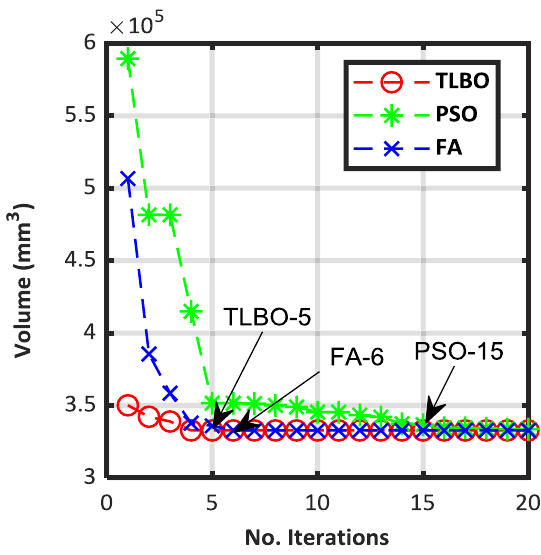
Fig. 9. Solid pro fi le convergence